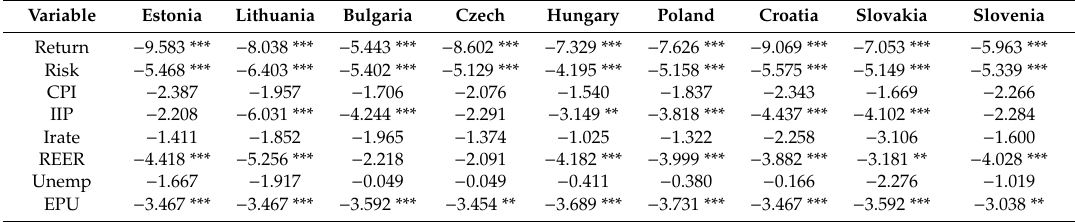
Table 1. Unit root test results, variables in